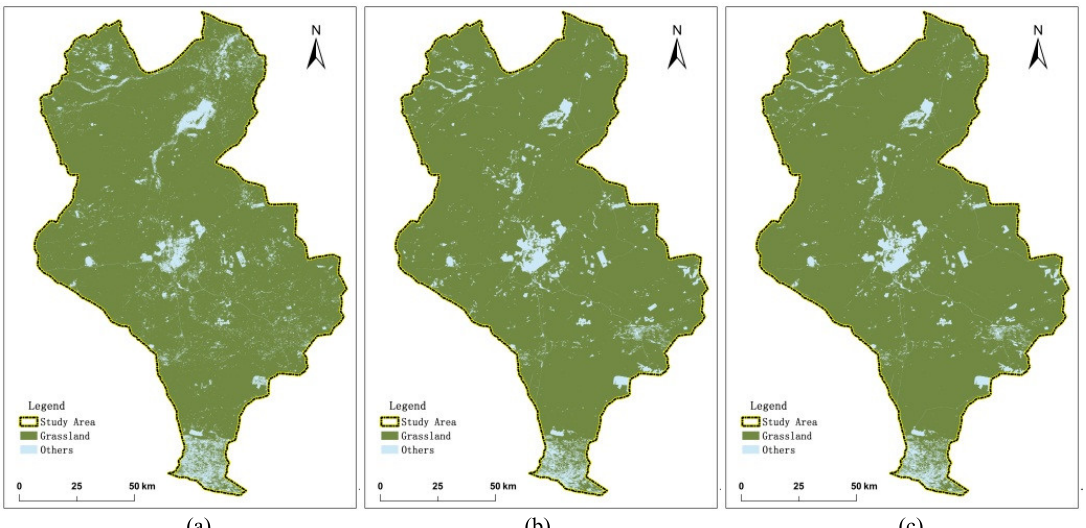
Figure 4 Comparison of grassland classification results.